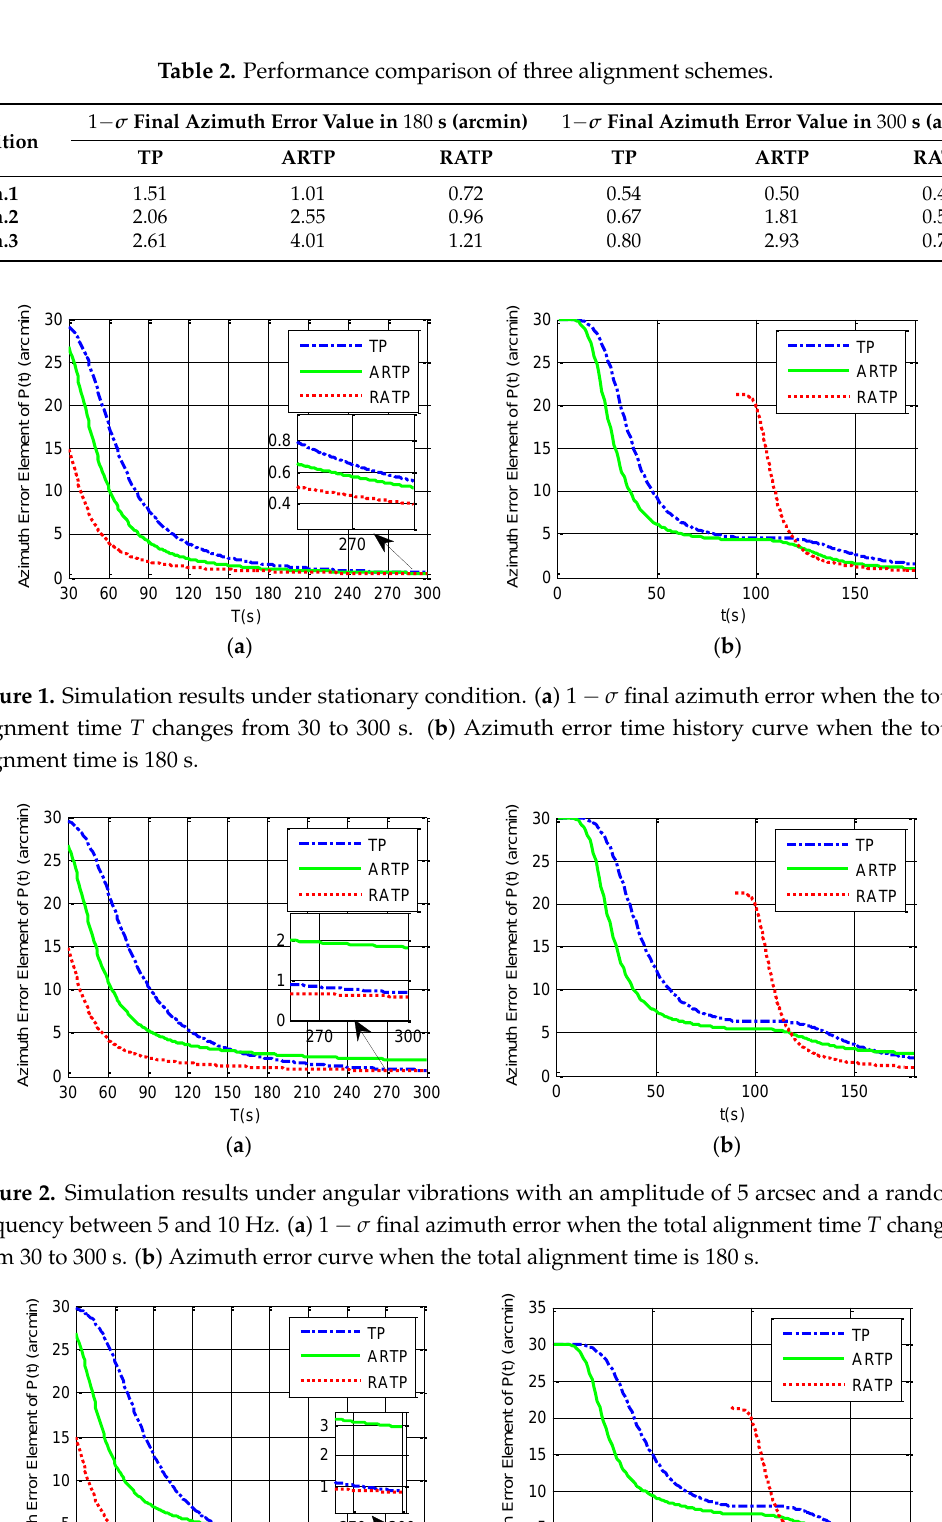
Table 2. Performance comparison of three alignment schemes.